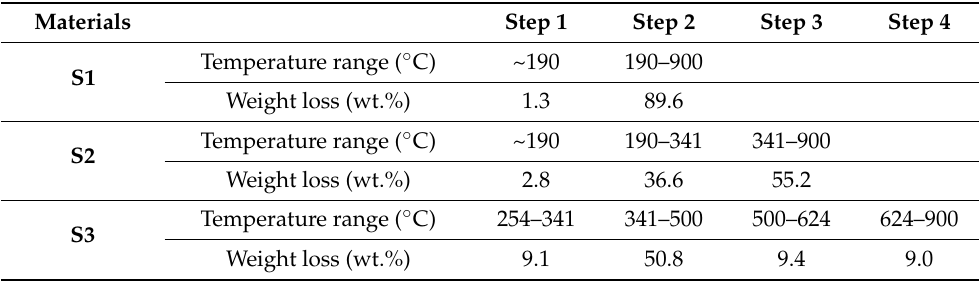
Figure 2. TGA and DTG curves of S1, S2, and S3. Table 1. Thermal properties of S1, S2, and S3.